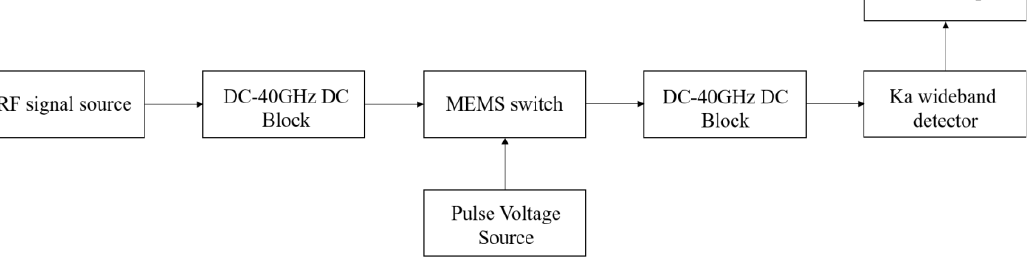
Figure 16. Block diagram of RF MEMS switch lifespan test platform.